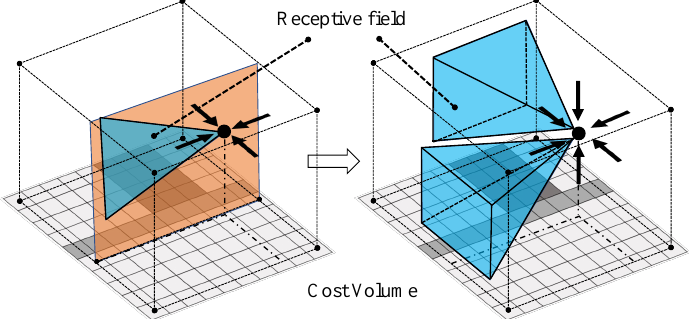
Figure 2. Illustration of the receptive field expansion in SGA layers. Left : Four-direction aggregation with 2D receptive field in the GANet. Right : Six-direction aggregation with 3D receptive field in Dual-GANet. The receptive fields are visualized with blue